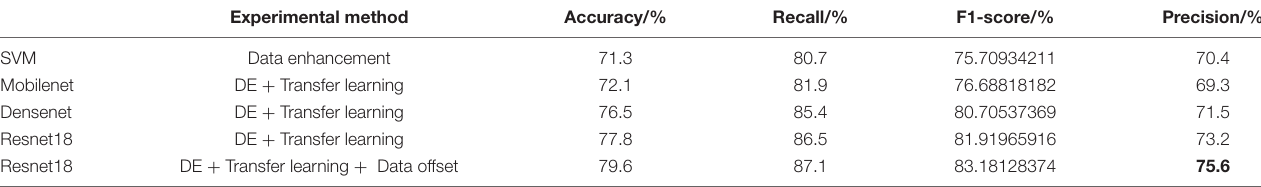
TABLE 4 | Results in machine